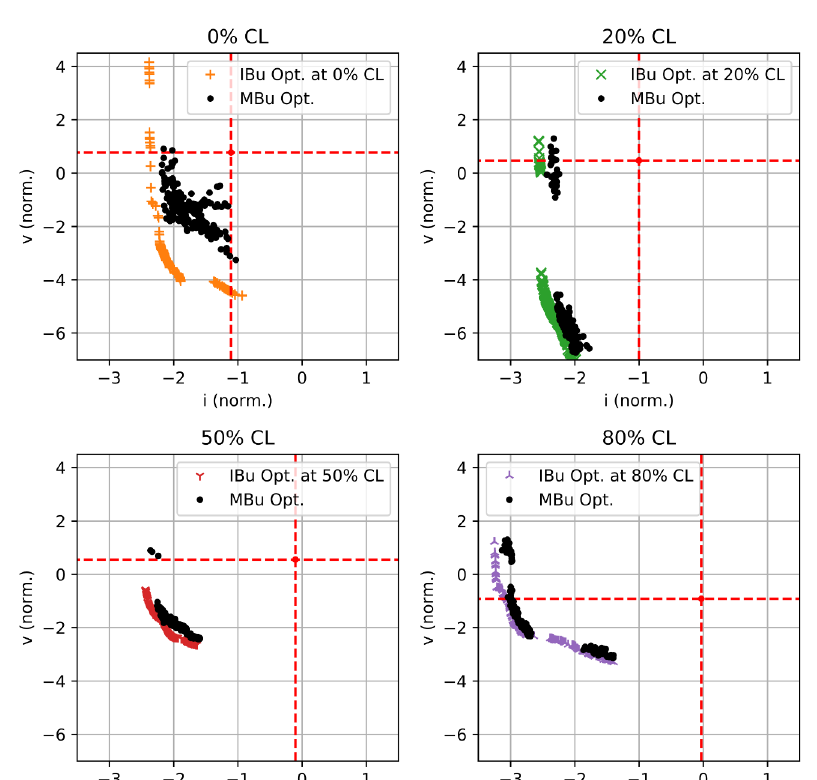
Figure 4: Performances of the MBu optimization compared to the one-point optimizations, at each burnup point. The dotted lines show the value of the objectives for the non-optimized